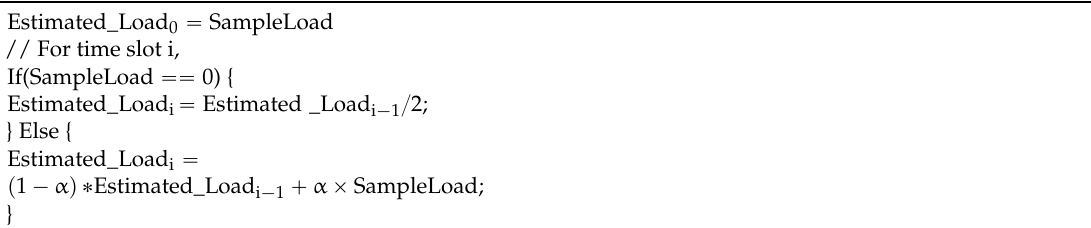
Table 2. Load Estimation Algorithm